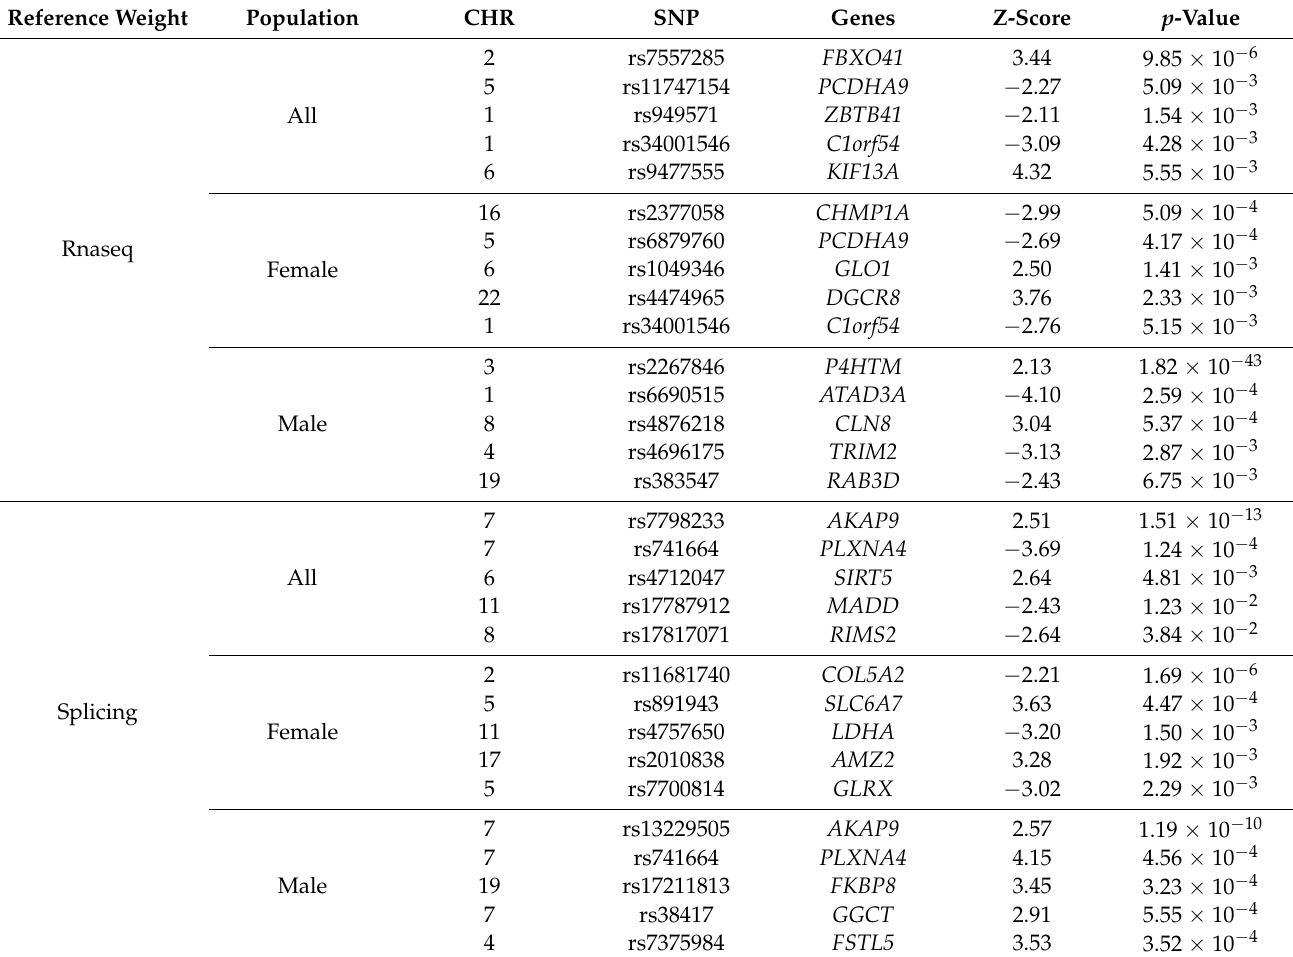
Table 2. Transcriptome-wide association study (TWAS) results for